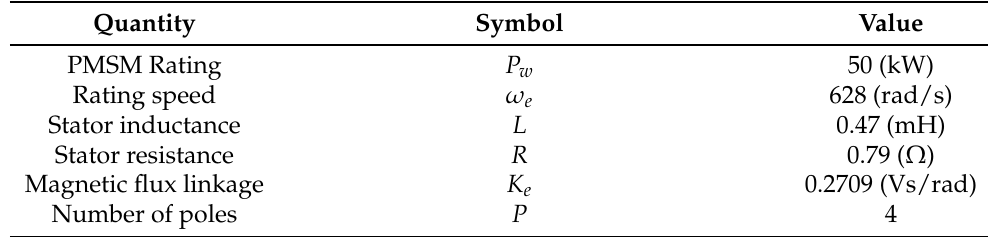
Table 1. Specifications of the